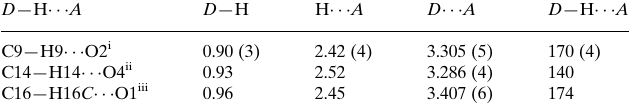
Hydrogen-bond geometry (A˚ , (cid:2)